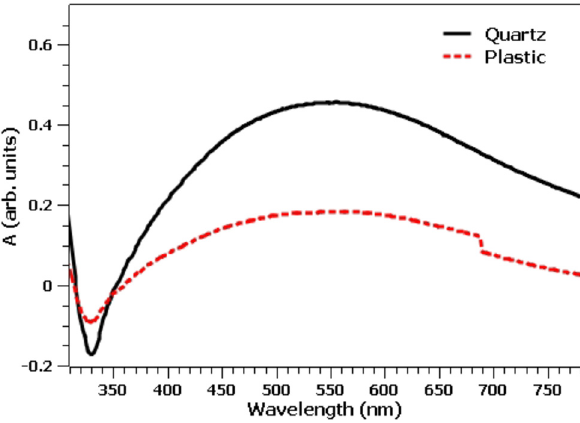
Figure 9: UV - Vis spectra of the same sample using cuvettes made of quartz and